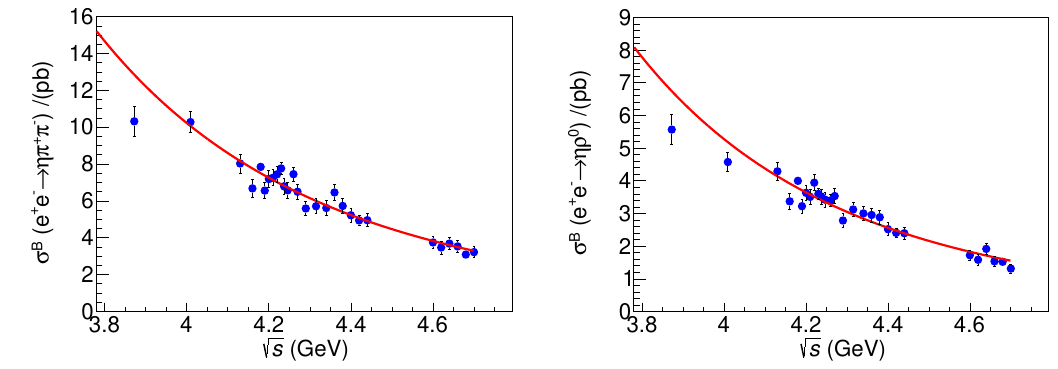
Figure 3 . Fit to the Born cross section with function a/s n (left) for the e + e − → ηπ + π − process and (right) for the e + e − → ηρ process. Here, the blue dots with error bars are the measured Born cross sections, and the red solid lines show the fit